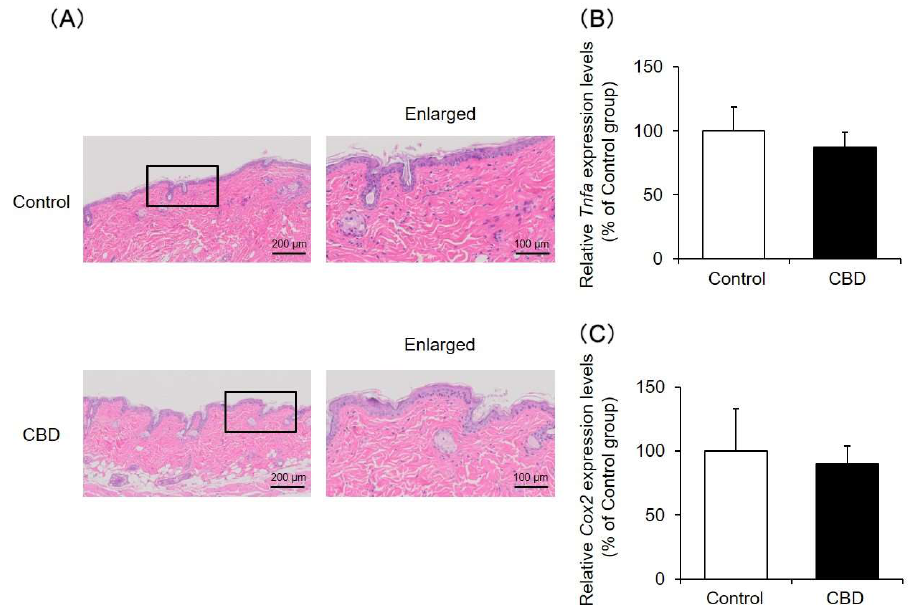
Figure 1. Skin tissue findings and inflammatory reactions. A 1% CBD solution was applied to the back skin of mice for 14 days. After the treatment, the skin was removed, and the tissue was assessed by HE staining ( A ). The mRNA expression levels of Tnfa ( B ) and Cox2 ( C ) in the skin were analyzed by real-time RT-PCR ( n = 6, means ± SD).